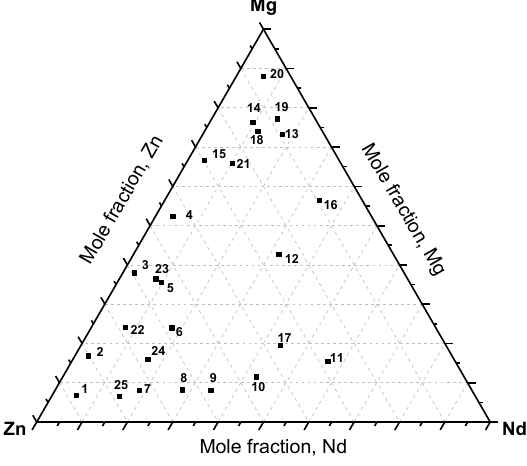
Figure 8. The actual composition of the Mg-Nd-Zn key alloys.